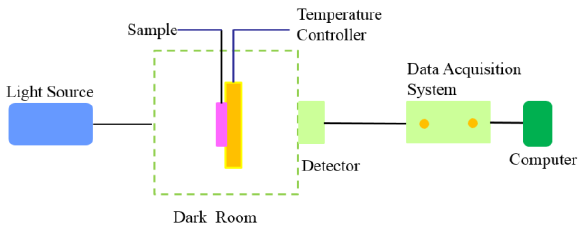
Figure 8. Schematic diagram of the transmittance measure